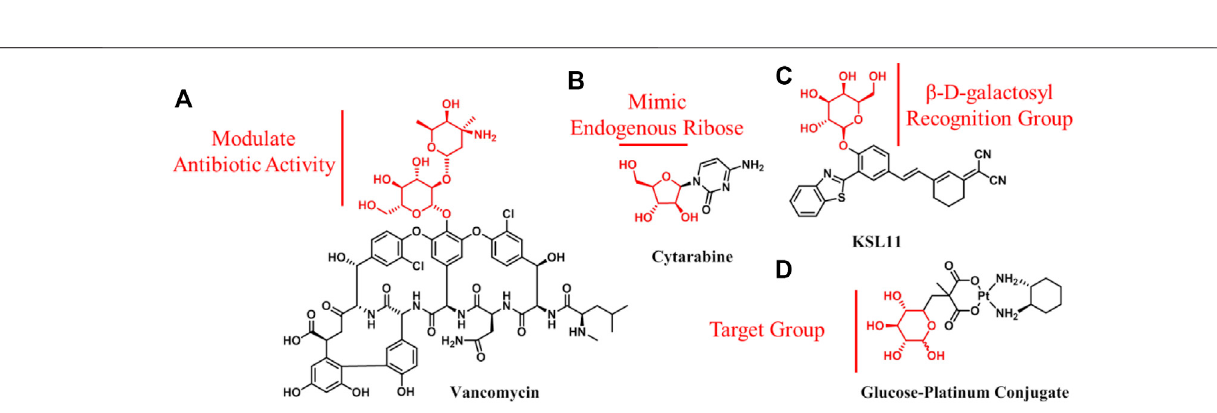
Frontiers in Pharmacology |